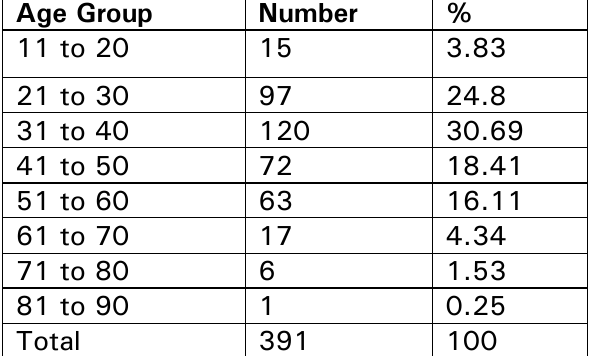
Picture 2: Accessory right hepatic duct draining Table 1: Distribution of the patients according to age group